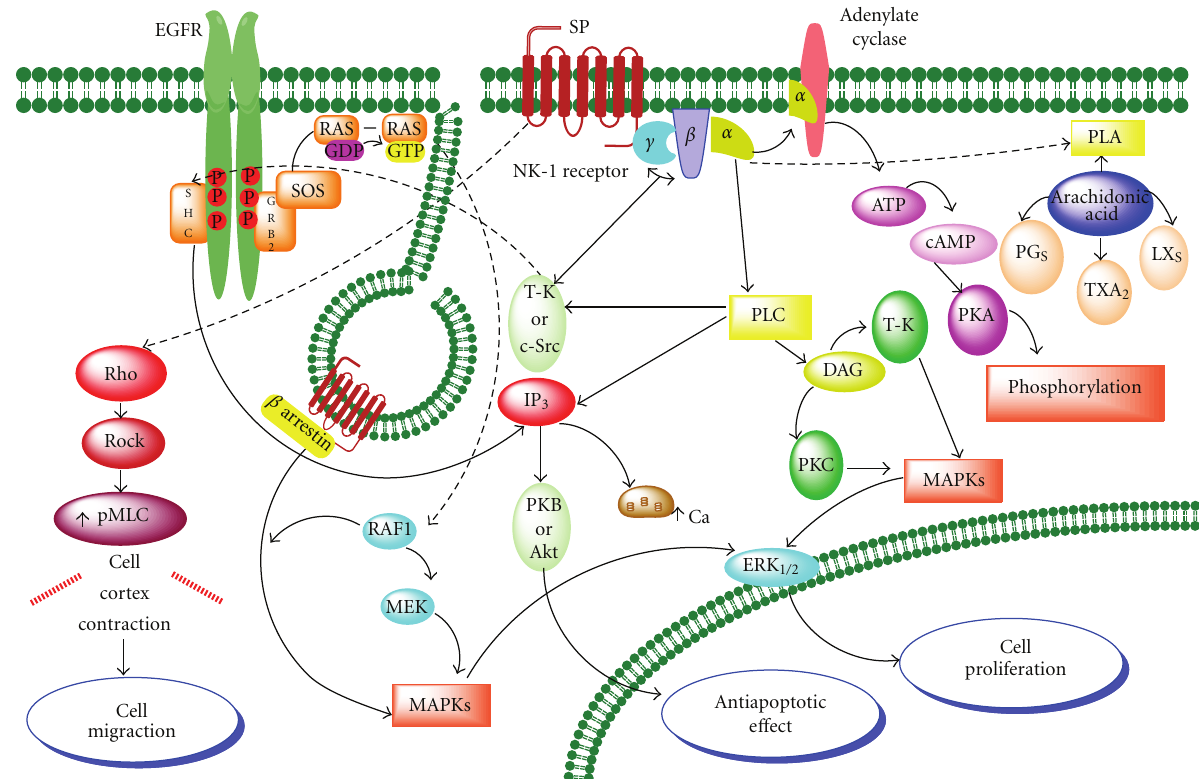
Figure 2: The downstream signaling pathways of the NK-1 receptor are shown. Activation of this receptor by SP leads to cell proliferation, antiapoptotic e ff ect, and cell migration (see detailed description in text. Amplified from Mu˜noz et al.